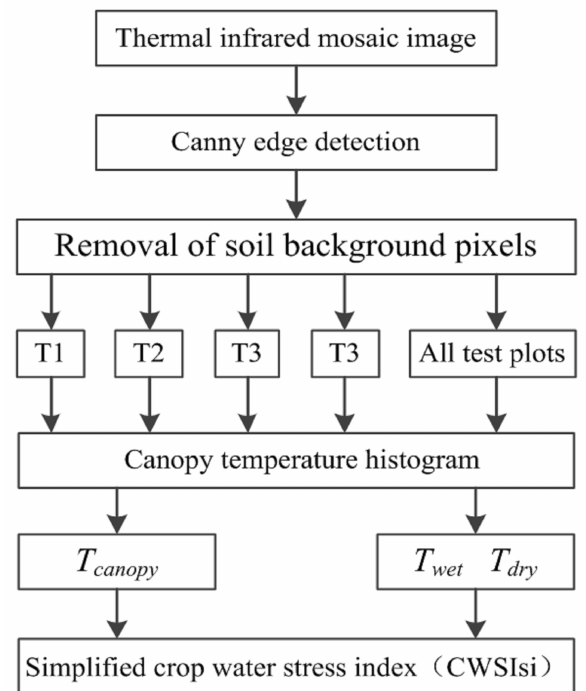
Figure 2. Flow chart on the calculation of the simplified crop water stress index using a cotton canopy temperature